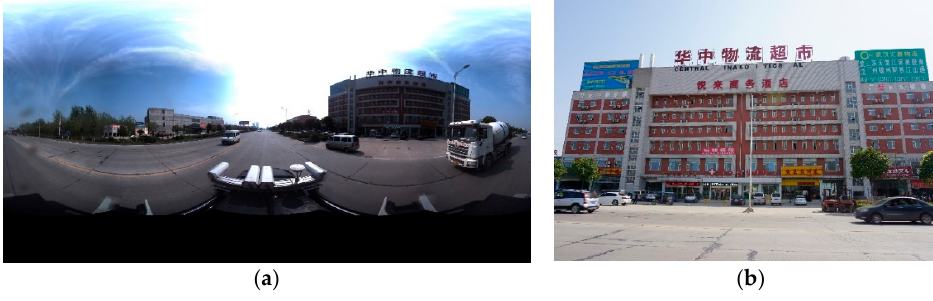
Figure 3. Comparison between ( a ) a panoramic image and ( b ) a frame image. (The meaning of the Chinese characters on the building is Supermarket for Logistics in Central China)